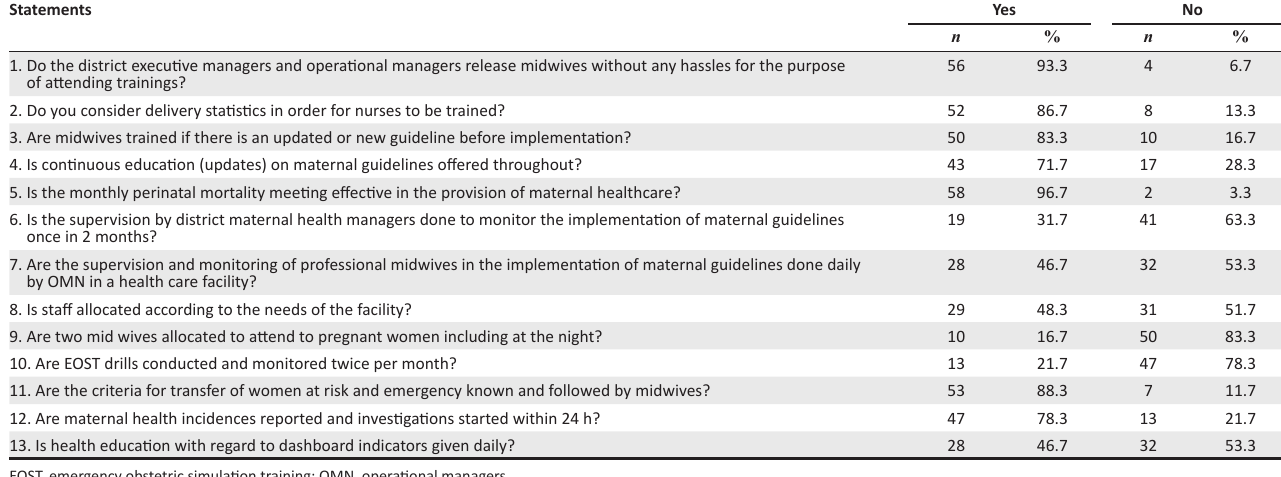
TABLE 2a: Support offered by managers related to capacity building to human resources.